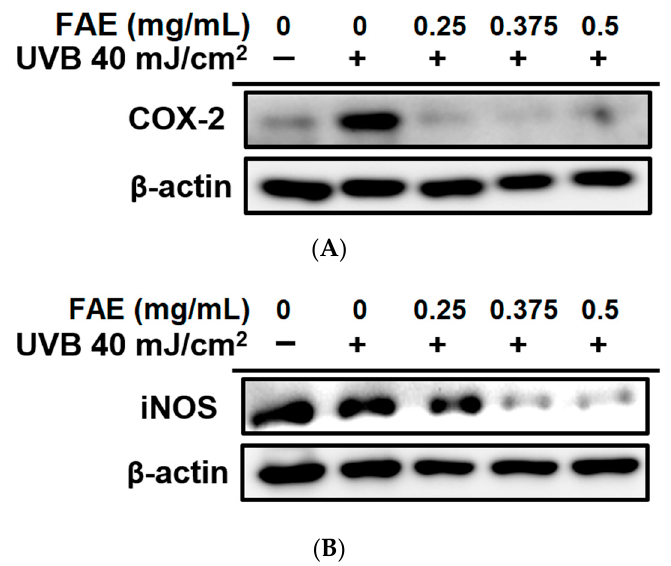
Figure 5. The effects of Ficus awkeotsang Makino extract (FAE) on UVB-irradiated protein expression of ( A ) cyclooxygenase-2 (COX-2), and ( B ) inducible nitric oxide synthase (iNOS) in Hs68 cells.